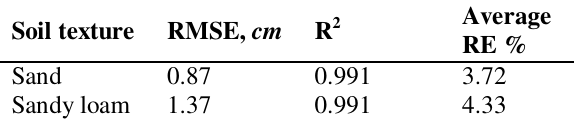
Statistical analysis of the comparison between wetting patterns width obtained by using HYDRUS/2D and those predicted by the empirical formulas. Soil texture